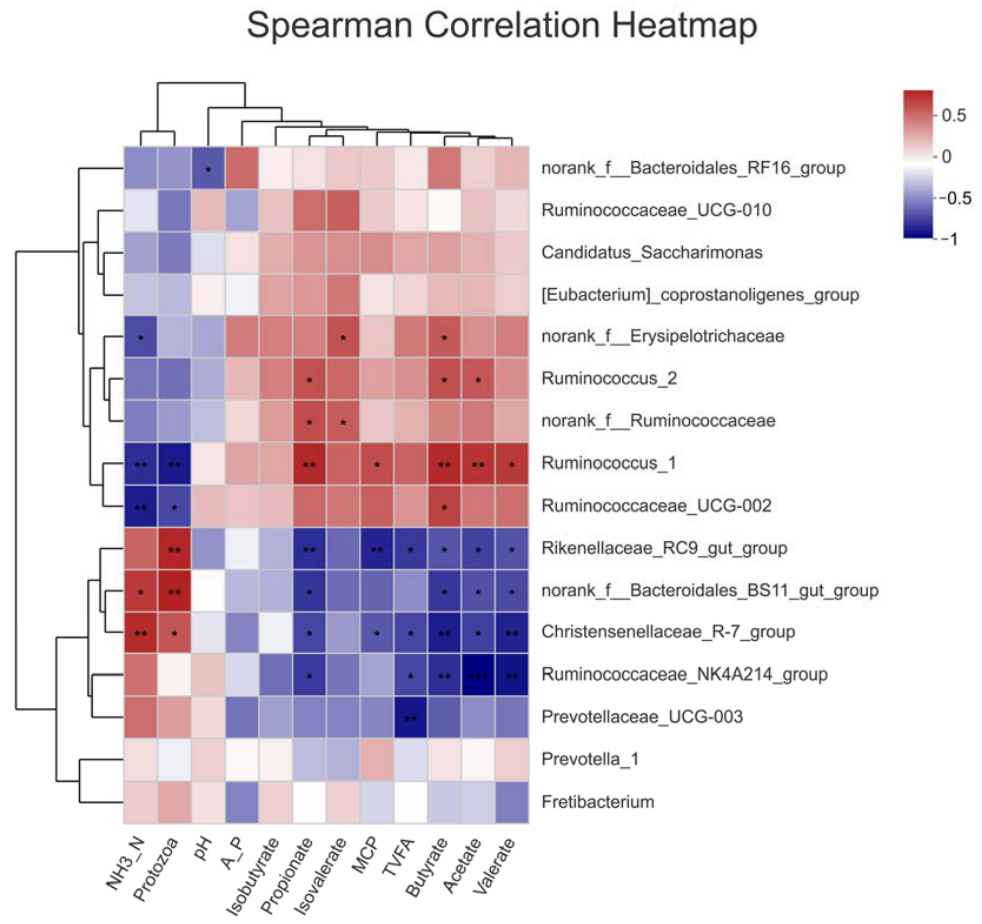
Figure 7. Spearman correlation analyses of the most abundant 25 bacterial genera with ruminal fermentation relevant variables in Exp. 2. Only genera with p ≤ 0.01 were concerned (* 0.01 < p ≤ 0.05, ** 0.001 < p ≤ 0.01, *** p ≤ 0.001).